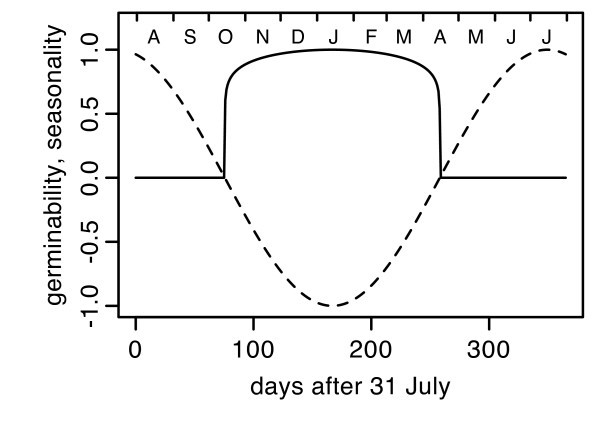
Time course of germinability and seasonality index. Continuous line: germinability, dashed line: seasonality index S.